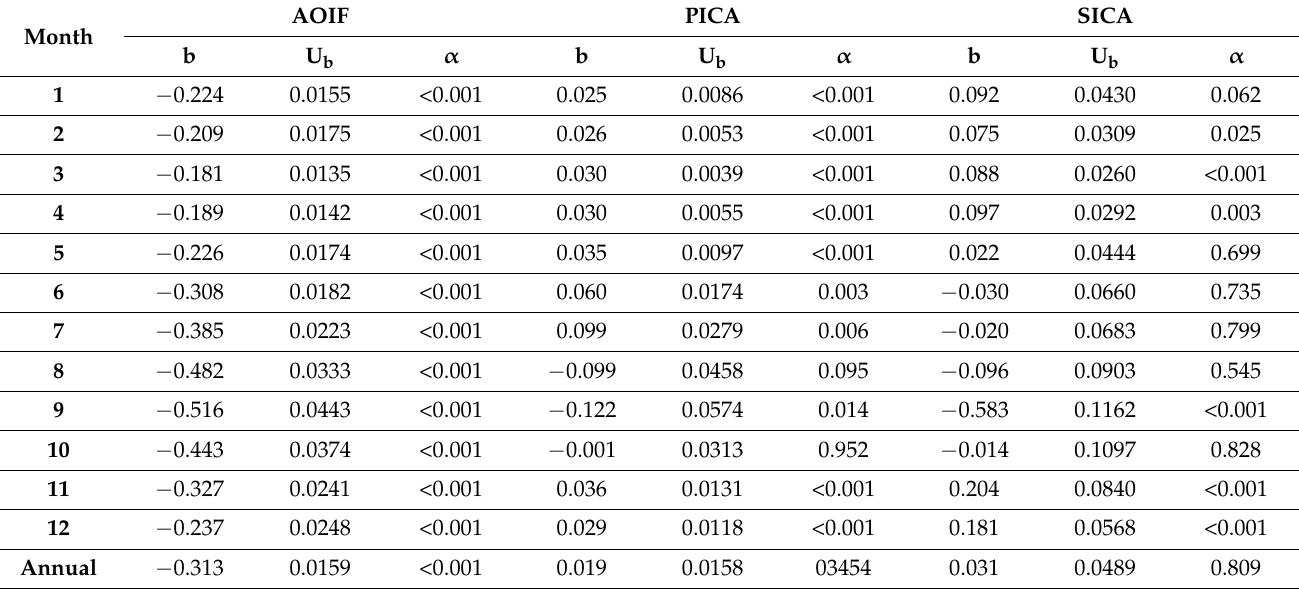
Table 2. Monthly mean SIC trend b (% per year) with its uncertainty U b and confidence level α for AOIF, PICA, and SICA over